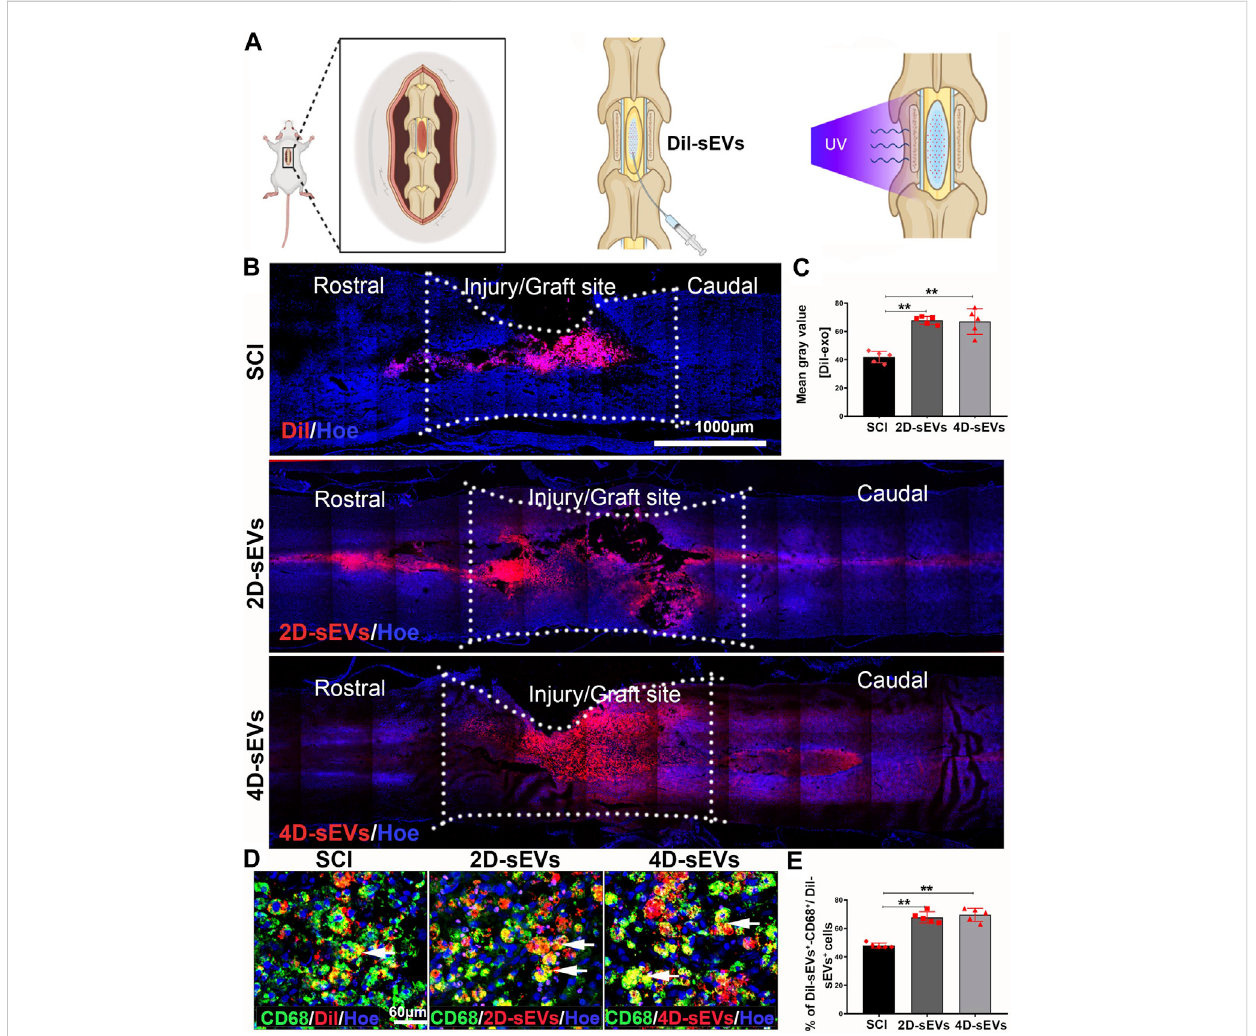
FIGURE 2 Four dimensional culture-derived sEVs are mainly taken up by macrophages in the in-jury/graft site of the spinal cord. (A) Schematic showing how sEVs are injected into the spinal cord. (B) Distribution and migration of sEVs in the injury/graft site of the spinal cord visualized using fl uorescent images. (C) Barcharts showingthemean fl uorescence intensity in threegroups within theinjury/graftsiteof thespinal cord. (D) The fl uorescently stained images show thattheCD68 + cellstake upDil andDil-sEVsintheinjury/graftsiteofthespinal cord. (E) Bar charts showingtheratiooftheDil-CD68 + cellsto Dil + cells in the injury/graft site of the spinal cord. Statistic difference: ** p <